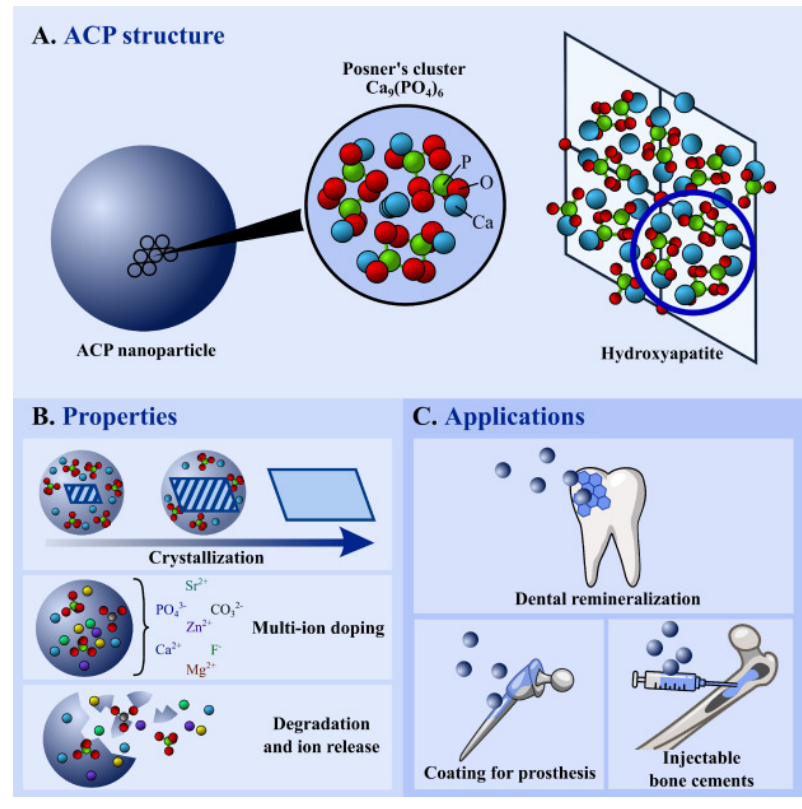
Figure 3. ( A ) Structure of ACP, and the relationship with HA unit cell, ( B ) properties, and ( C ) bio- medical applications [44]. ical applications